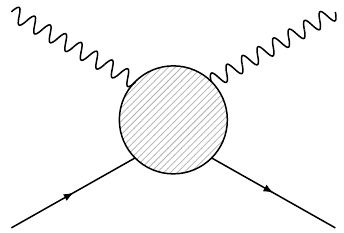
Figure 1. Compton scattering. The solid lines represent a massive spin- s particle, with the flow of momentum shown by the arrows. The wavy lines represent bosons being emitted from the massive